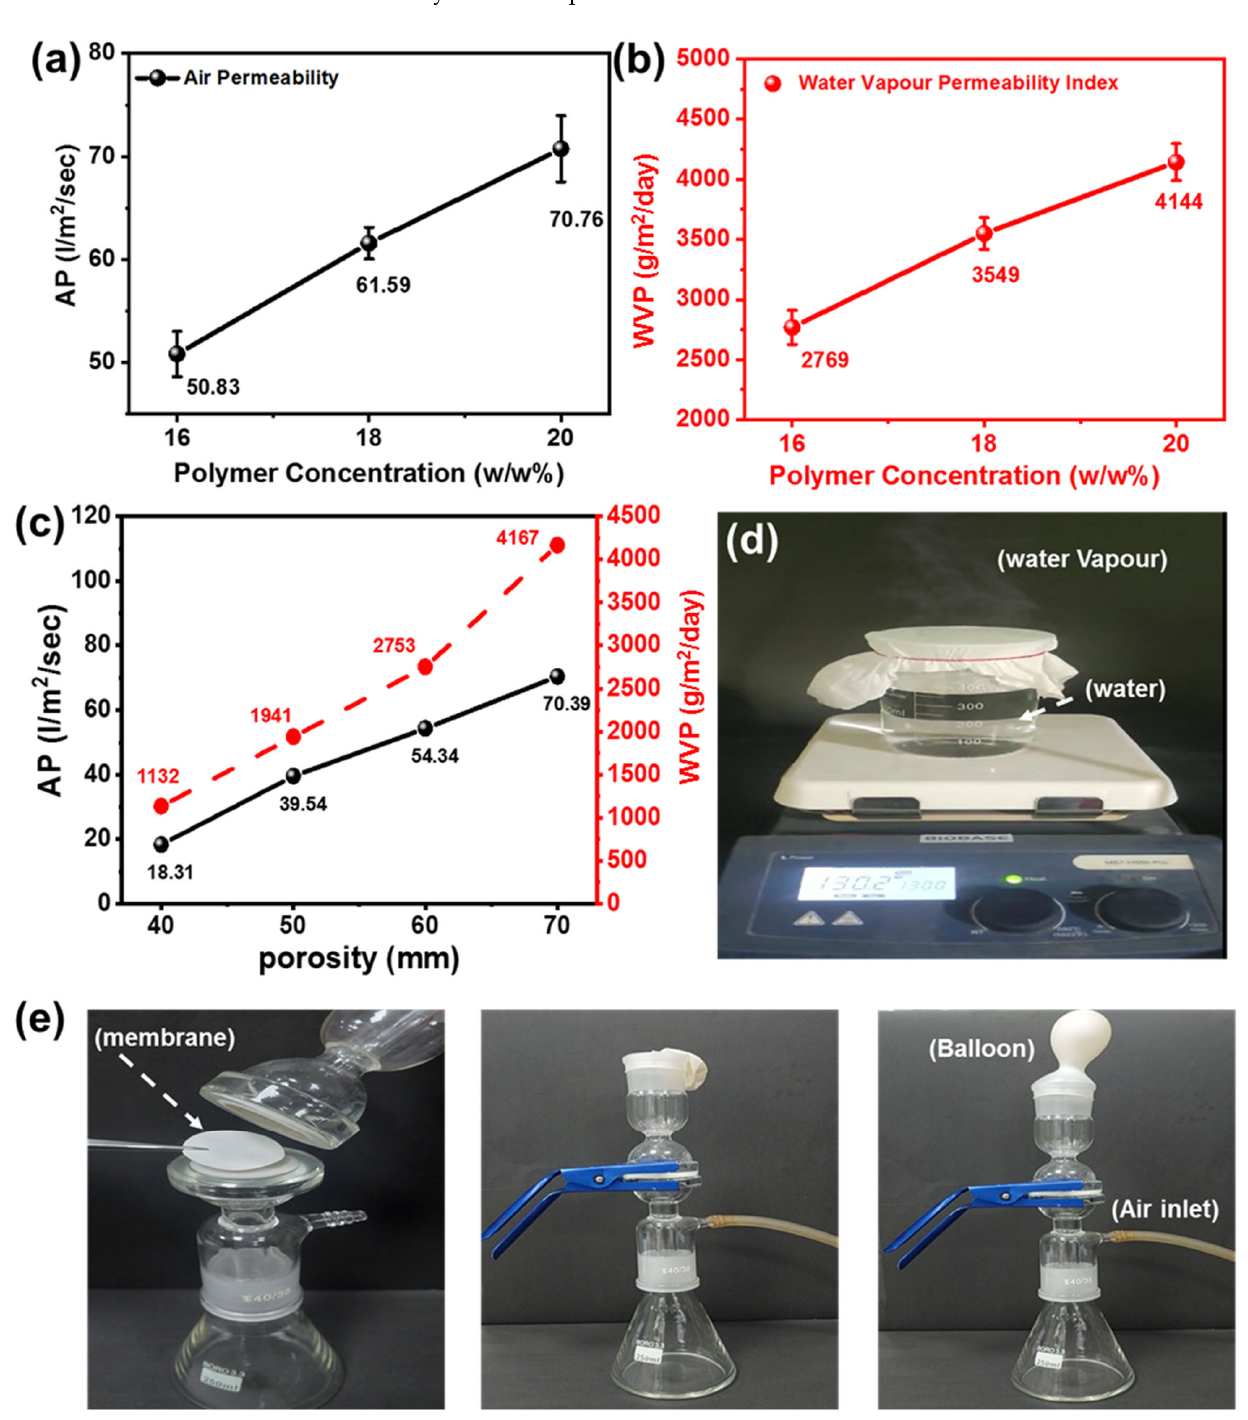
Figure 8 . ( a , b ) In fl uence of the polymer concentration on the AP and WVP of the composite PU − NFs membrane, containing 6% SiO 2 -NP; ( c ) impact of the porosity of composite PU − NFs membrane on the air permeability and WVP; ( d , e ) self-developed techniques were employed to demonstrate the breathability of the nano fi brous